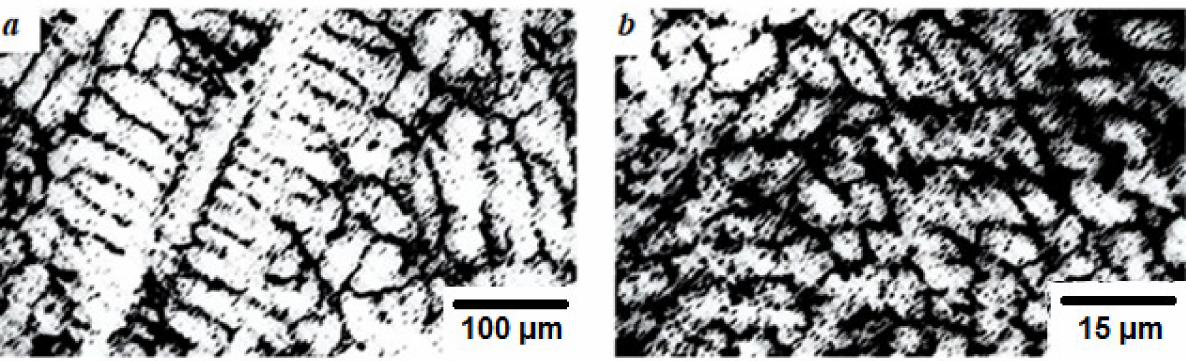
Figure 3. Dendritic structure of heat-resistant alloy: ( a ) 50 × and ( b ) 400 × .